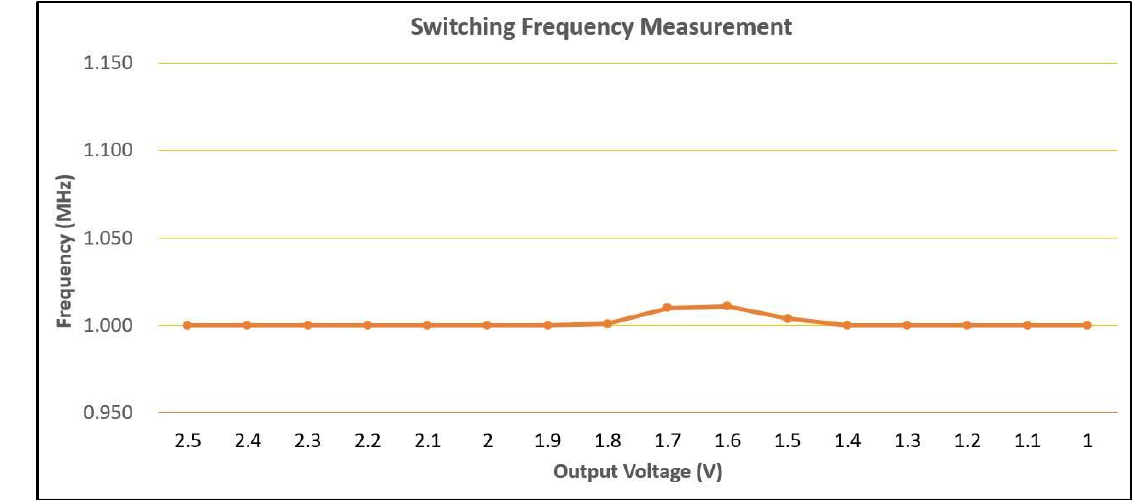
Figure 12. The measurements of the switching frequency.